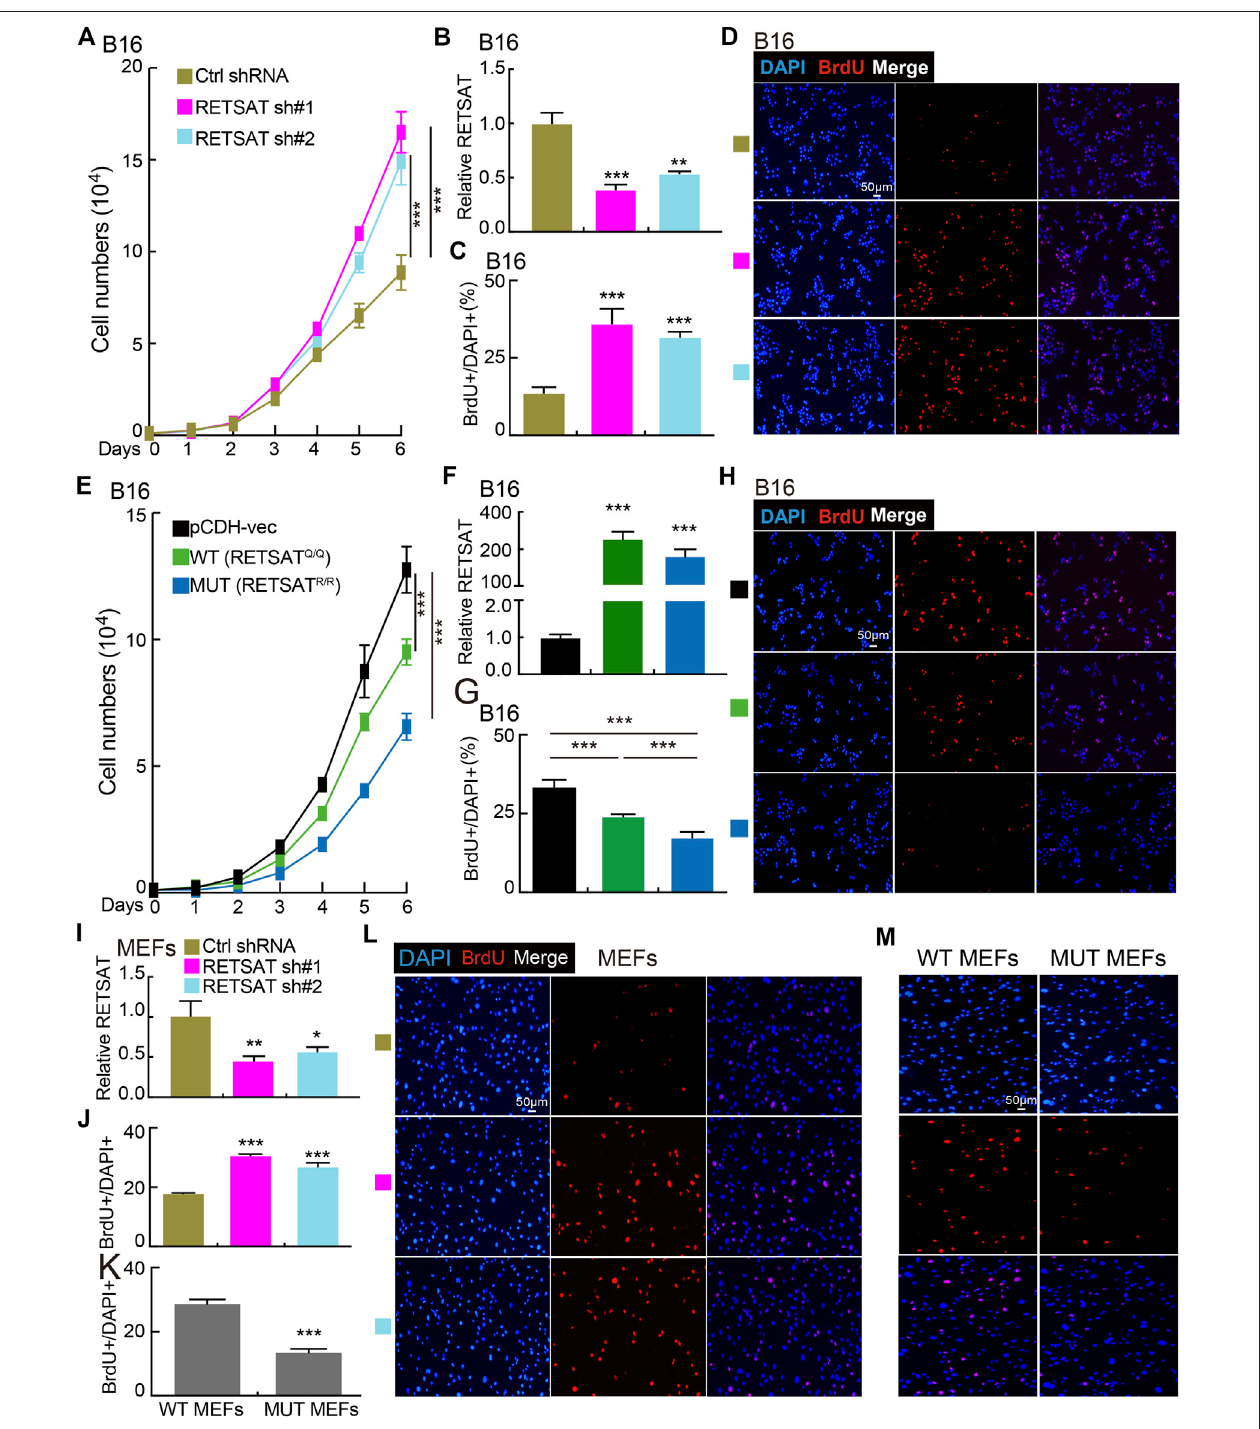
FIGURE4| RETSATknockdown promotescellproliferation. (A) KnockdownofRETSATpromotesB16cellgrowth examinedbygrowth curveassay. (B) RETSAT targetingshRNAknockdownef fi ciencyinB16cellswasveri fi edbyReal-timeRT-PCRassay,scrambleshRNAwasusedascontrol.sh#1 (cid:1) shRNA#1,sh#2 (cid:1) shRNA#2, Ctrl (cid:1) control. (C,D) Knockdown of RETSAT promotes B16 cell proliferation examined by BrdU incorporation assay, (C) is the quanti fi cation data for (D) . Scale bar (cid:1) 50 μ m. (E) Overexpression of RETSAT inhibits B16 cell proliferation examined by growth curve assay. (F) RETSAT overexpression ef fi ciency in B16 cells was veri fi edbyReal-timeRT-PCRassay. (G,H) RETSAToverexpressioninhibitsB16cellproliferationexaminedbyBrdUincorporationassay, (G) isthequanti fi cationdatafor (H) . Scale bar (cid:1) 50 μ m. (I) RETSAT targeting shRNA knockdown in wild-type MEFs was veri fi ed by Real-time RT-PCR assay. (J,L) RETSAT inhibition promotes cell proliferation in MEFs examined by BrdU incorporation assay, (L) is the quanti fi cation data for (J) . Scale bar (cid:1) 50 μ m. (K,M) RETSATR/R mutant MEFs exhibit higher proliferation rate compared to wild type RETSATQ/Q MEFs, (M) is the quanti fi cation data for (L) . Scale bar (cid:1) 50 μ m. WT (cid:1) wild type (RETSATQ/Q). MUT (cid:1) mutant (RETSATR/R).* p < 0.05, ** p < 0.01, *** p < 0.001.